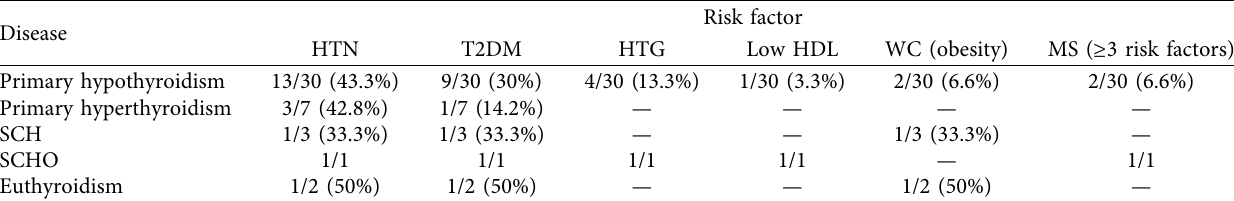
Table 4: Prevalence of metabolic syndrome or any risk factors of metabolic syndrome in thyroid dysfunction.